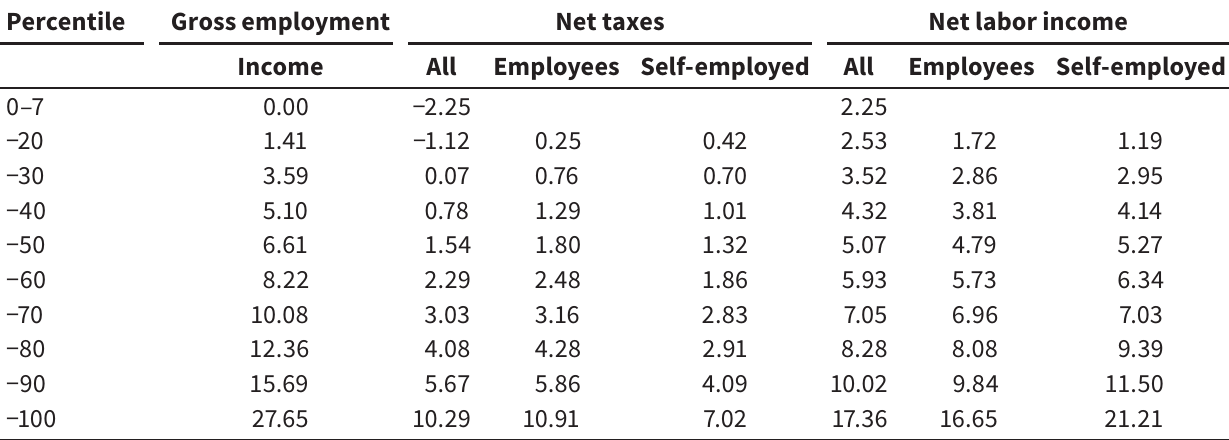
Statutory equivalized gross employment income, net taxes, and net labor income in thousand Euro per